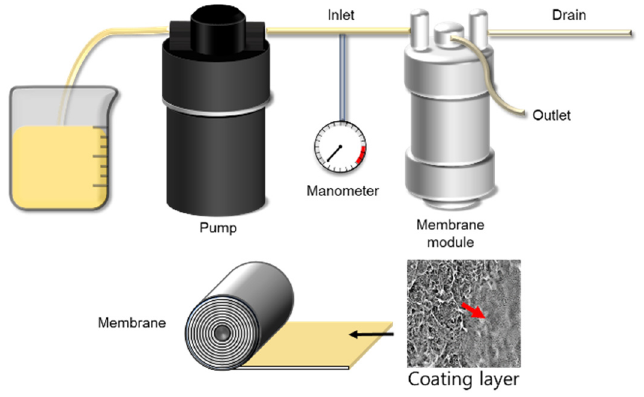
Figure 2. NF membrane module coating process via a simple circulation